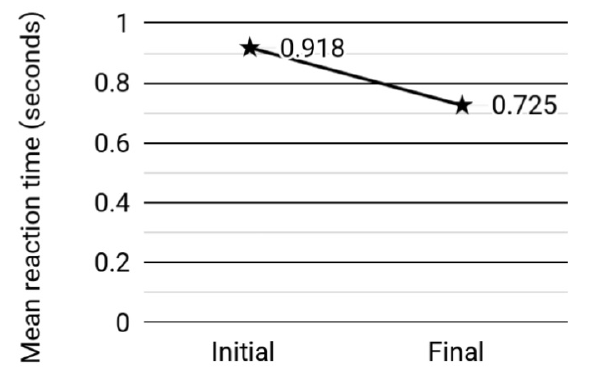
Figure 2. Change in reaction